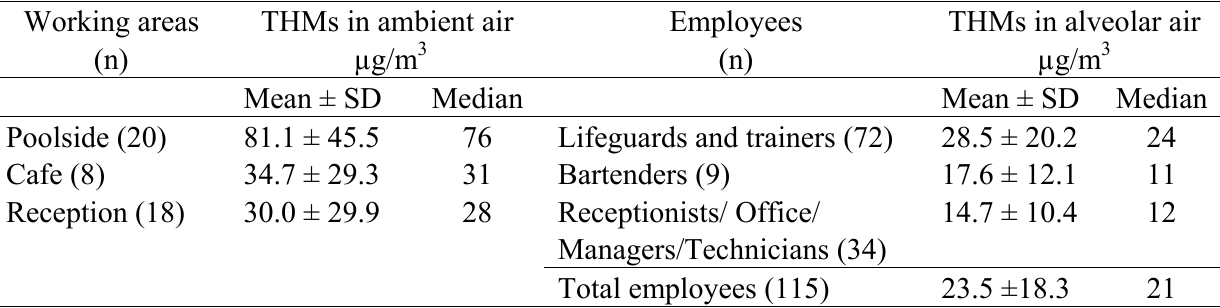
Table 3. THMs concentrations in ambient air samples collected from different working areas at indoor swimming pool facilities and THMs values in alveolar air samples from the investigated